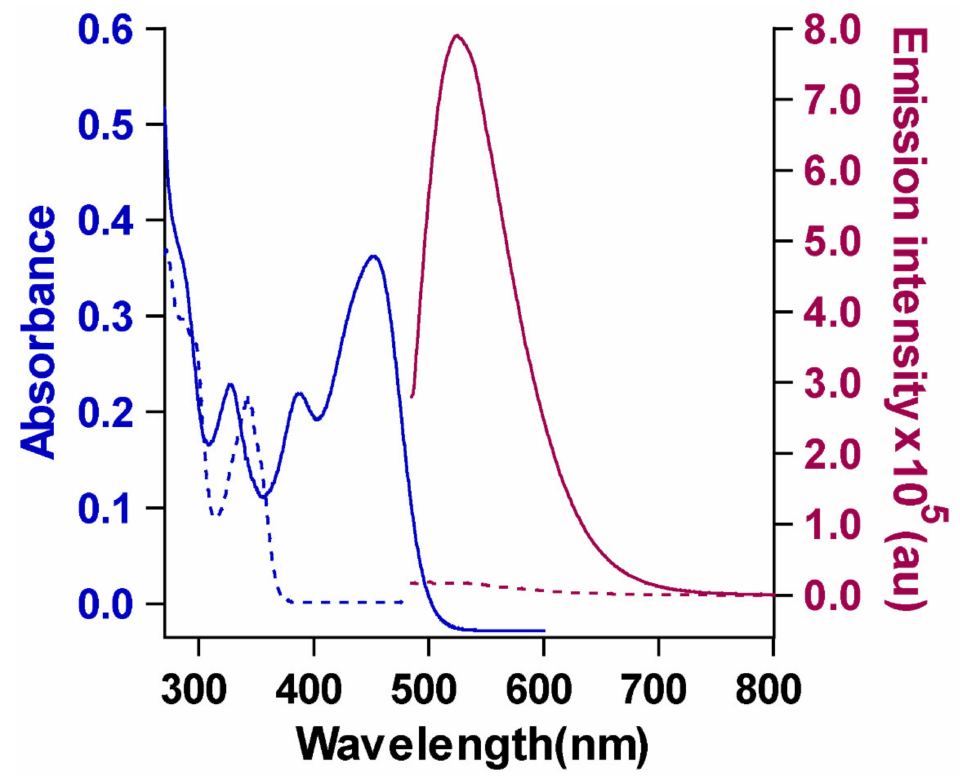
Figure 1. Absorption and emission profiles of (1) (10 µ M) and CB (10 µ M) in DMSO ( λ ex = 465 nm). The dotted lines correspond to the absorption and emission spectra of starting material (1) and the continuous lines correspond to that of CB. The absorption spectra showed a peak shift from 343 nm (starting material) to 450 nm (CB) while the emission λ max shifted from 499 nm for the starting material to 524 nm for